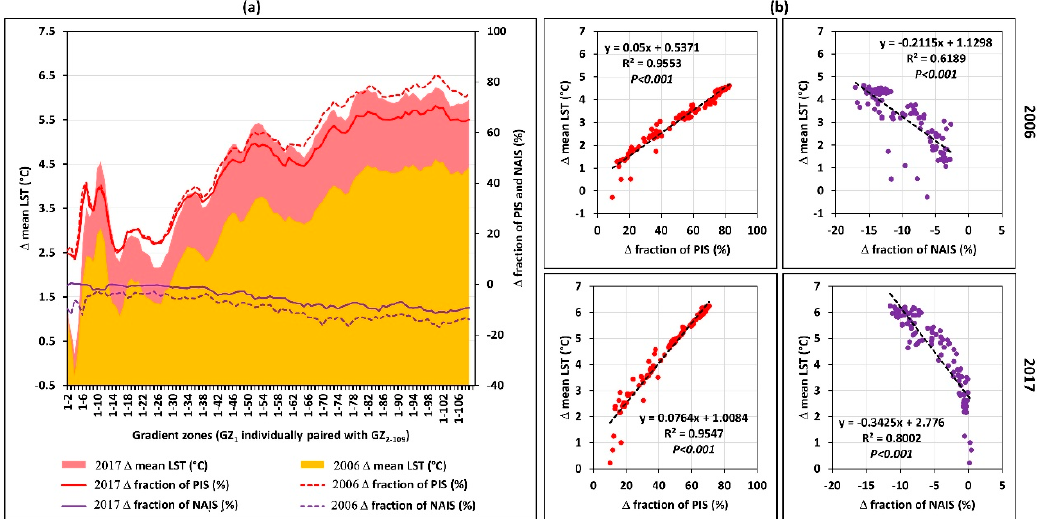
Figure 6. ( a ) Magnitude of Surface Urban Heat Island Intensity (SUHII) trend and fractional difference of PIS and NAIS along the GZs; ( b ) scatter plots and statistical relationship between SUHII magnitude and fractional difference of PIS and NAIS in 2006 and 2017.